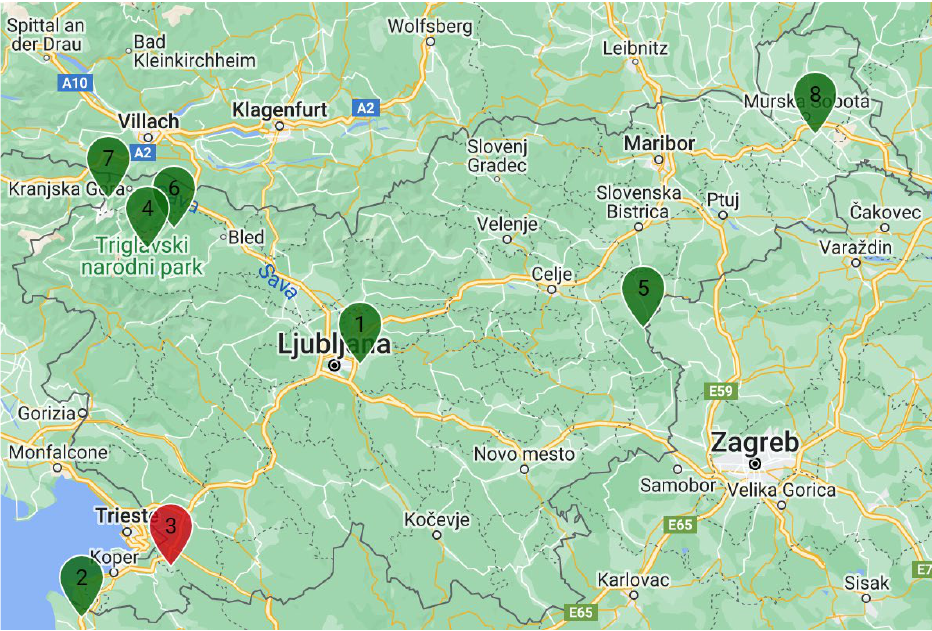
Figure 2. Locations of active ( green ) and inactive ( red ) SLONIP stations (base map source: Google Maps). The numbers correspond to upload on the website and not to Station ID. Table 1. SLONIP station attributes. ARSO — Slovenian Environmental Agency; JSI — Jožef Stefan In- stitute.